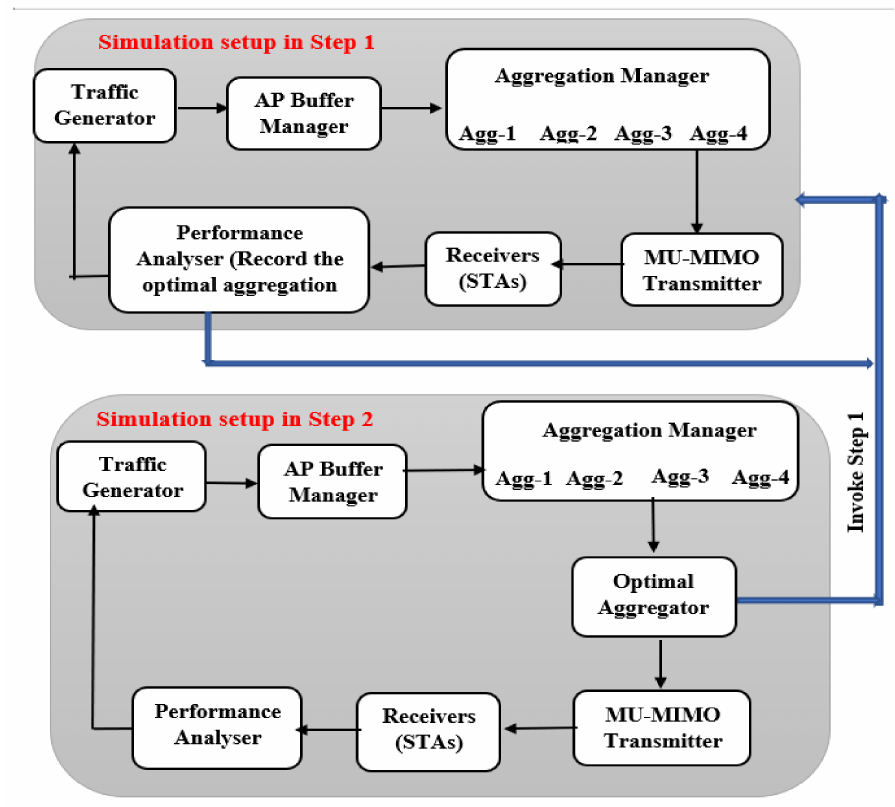
Figure 3. Interaction diagram for the simulation setups Step 1 and Step